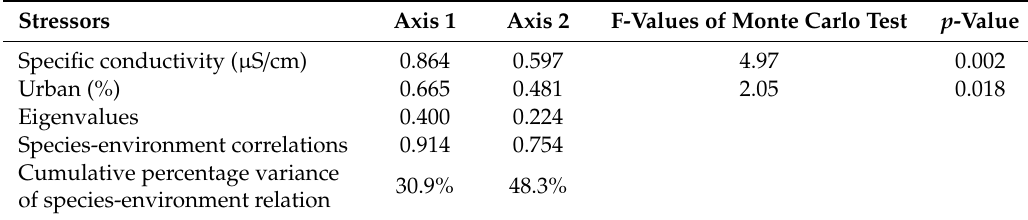
Table 3. Monte Carlo unrestricted permutation test of stressors and fish taxonomic structure in pCCA.